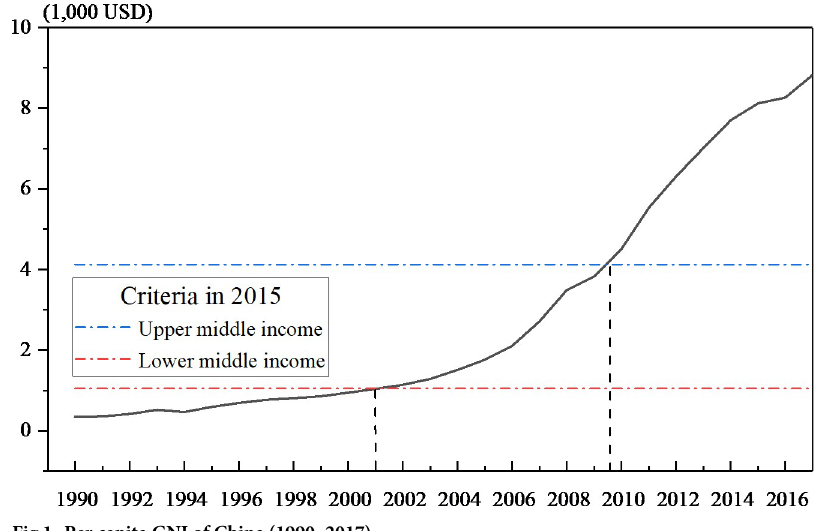
Fig 1. Per capita GNI of China (1990–2017).